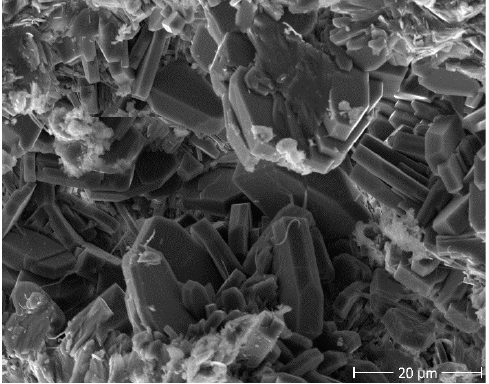
Figure 2. SEM image of the zeolitic tuff sample.